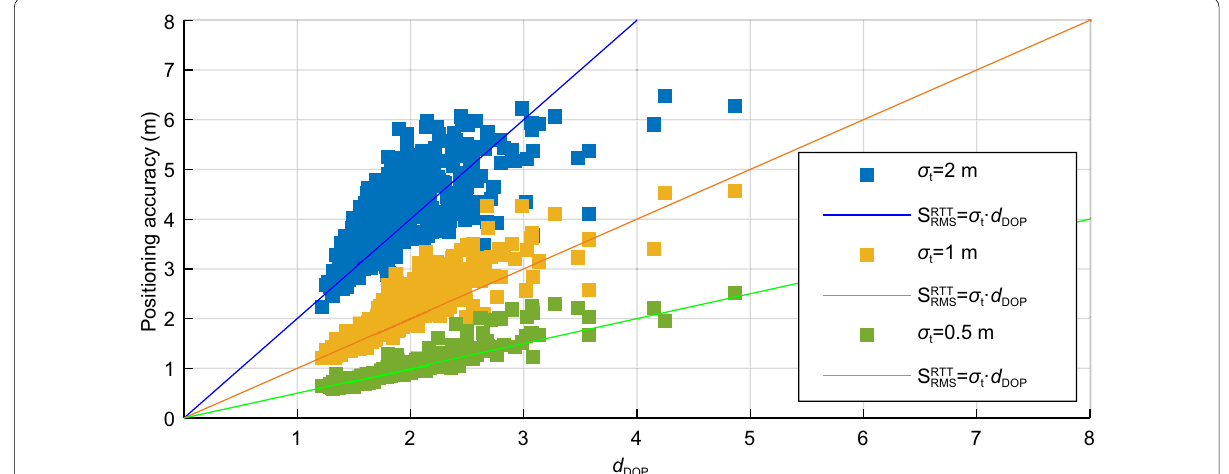
Fig. 6 Relationship between positioning accuracy and observation accuracy in Multi-RTT